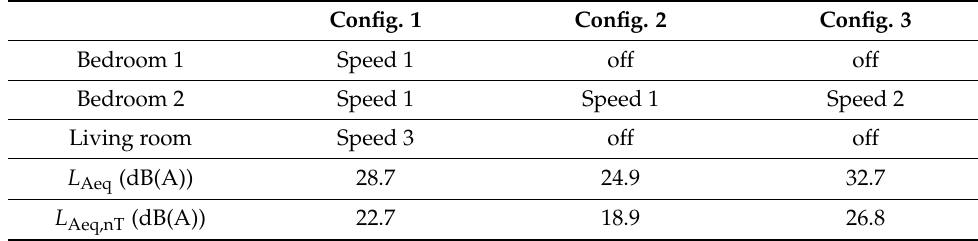
Figure 7. Sound pressure levels corrected with the background noise and the reverberation time, L Aeq,nT . The sound pressure levels corrected with the background noise, L Aeq , and corrected with the reverberation time, L Aeq,nT , are shown in Table 5. Table 5. Measured sound pressure levels.